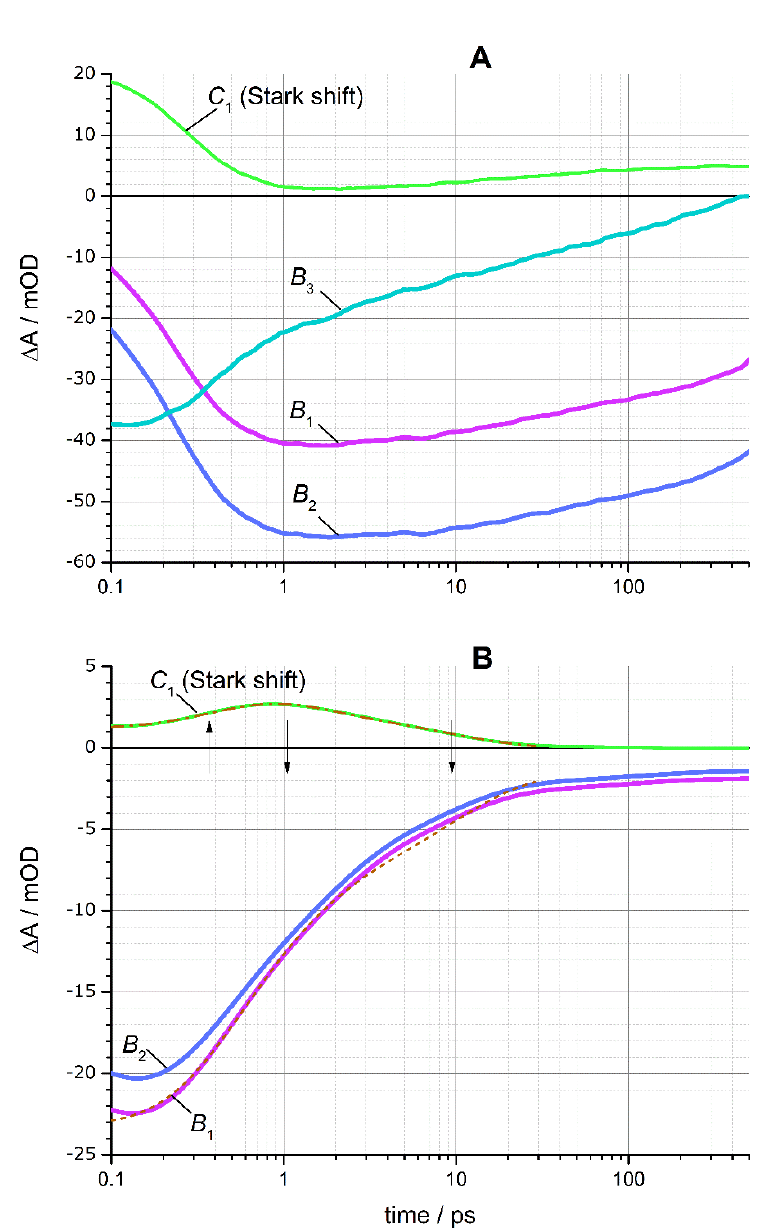
Figure 8. Kinetics of the B 1,2,3 ( t ) bleach peaks amplitude and the C 1 ( t ) amplitude associated with the electrochromic Stark shift of the band-edge exciton X 1 . ( A ) QD-1 sample without Mn 2+ ions. Green solid line is the experimental Stark shift. ( B ) QD-2 sample doped with Mn 2+ . Green solid line is the experimental Stark shift, red dash-dotted line is the model (5). The fitting of TA spectra from Figure 5A,B by 3 and 2 Gaussian components, respectively, was done using Equation (3) as illustrated in Figure 7. The kinetic model (4) of sequential electron-hole transfer in the Mn 2+ -doped QD-2 sample is shown by dashed lines according to eq. 5. Up and down arrows indicate the characteristic times of electron and hole transfer processes, respectively .